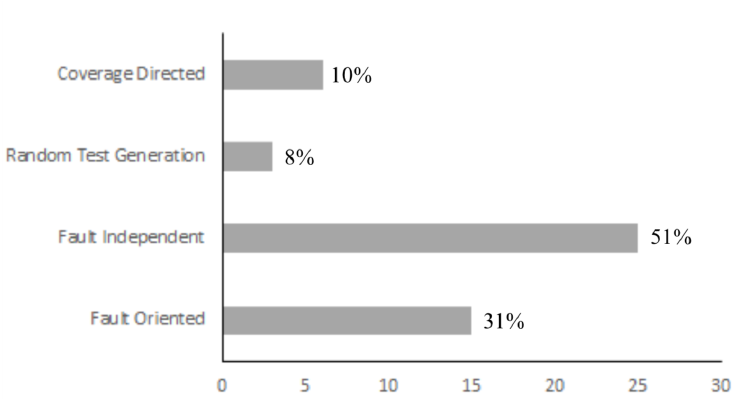
Figure 7. Distribution of studies based on the test